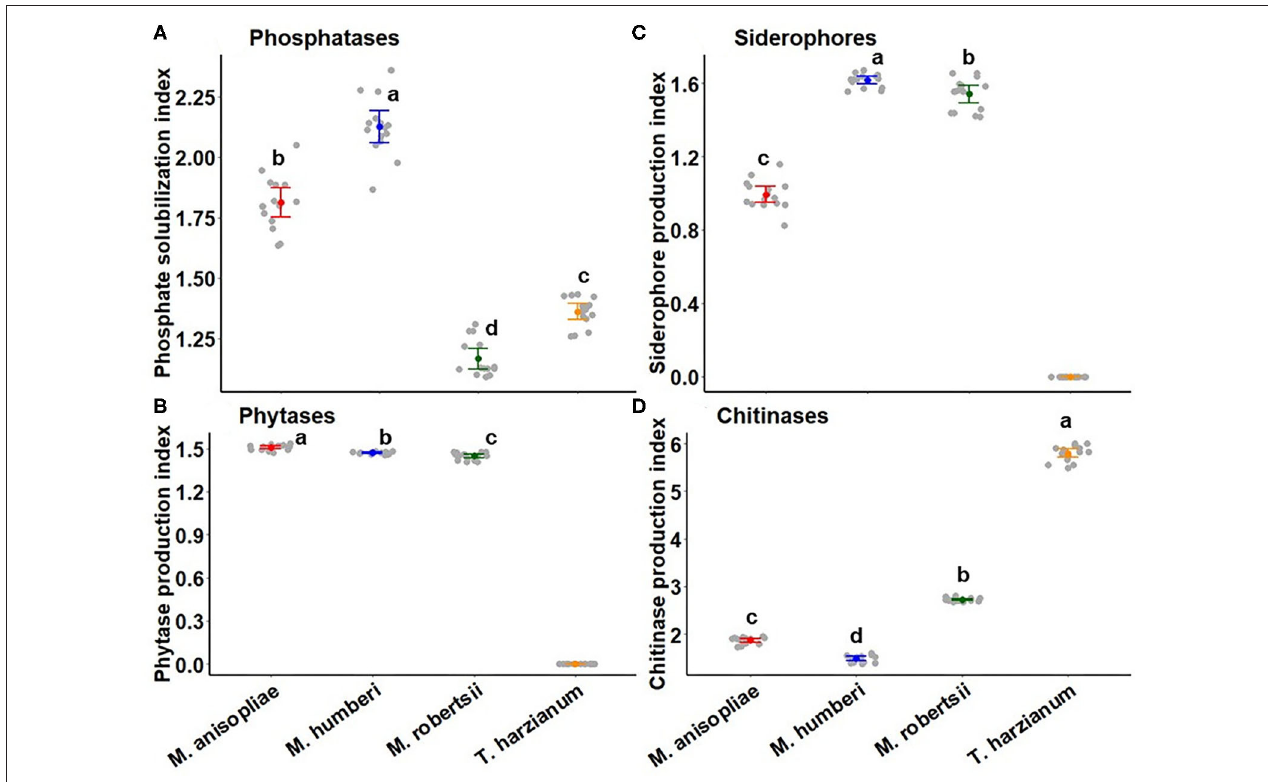
FIGURE 7 | Biochemical profile of Metarhizium species and T. harzianum (as control) by measuring the solubilization or production index after 15 days of growth on specific solid medium to determine the activity of phosphatase (A) , phytase (B) , siderophore (C) , and chitinase (D) . Segdots (dots with error bars) indicate means ± 95% CI (confidence intervals), while gray circles represent observed values ( n = 15 per fungus). Statistical contrasts were performed with Tukey HSD method at P < 0.05 and indicated by different letters. Note: where the mean is zero for some biochemical compounds attributed to T. harzianum , there is no statistical letter for